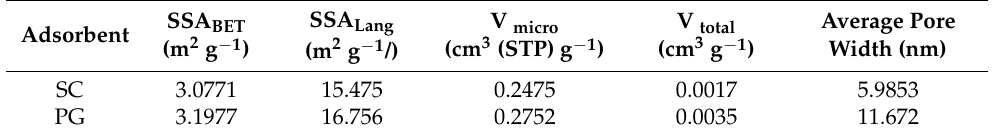
Figure 1. ( a ) Isotherms of N2 adsorption–desorption for SC and PG and ( b ) distribution of pore size.